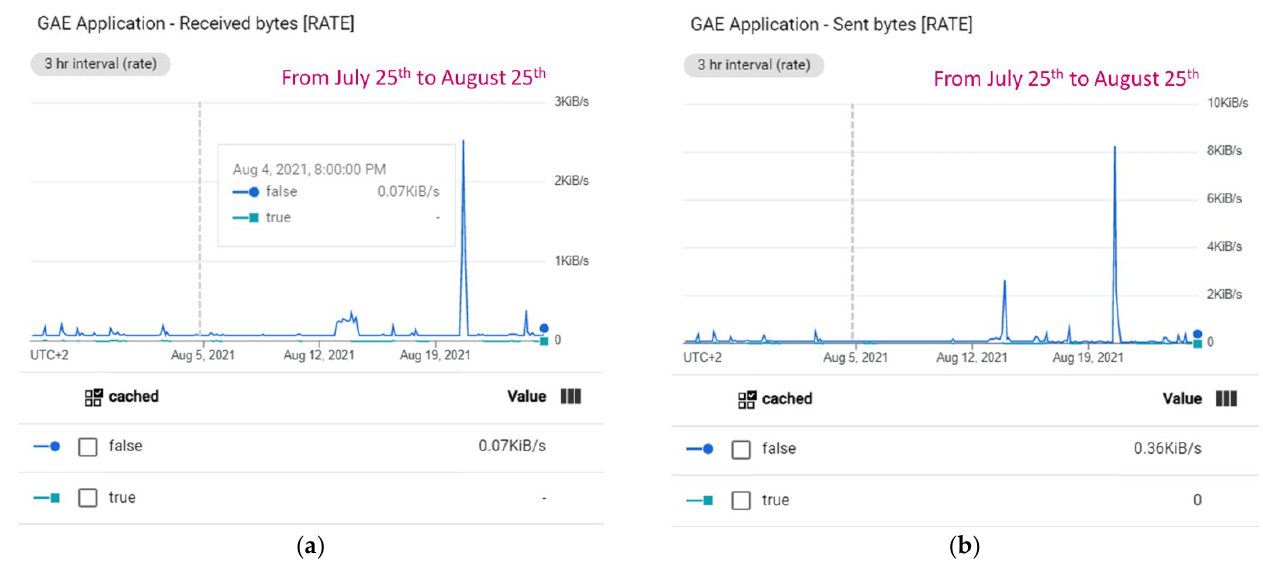
Figure 16. Other statistics related to byte rate which are received and sent when the application in the backend is running. ( a ) Received byte rate is under 0.25 KiB/s. ( b ) Sent byte rate is under 0.36 KiB/s.